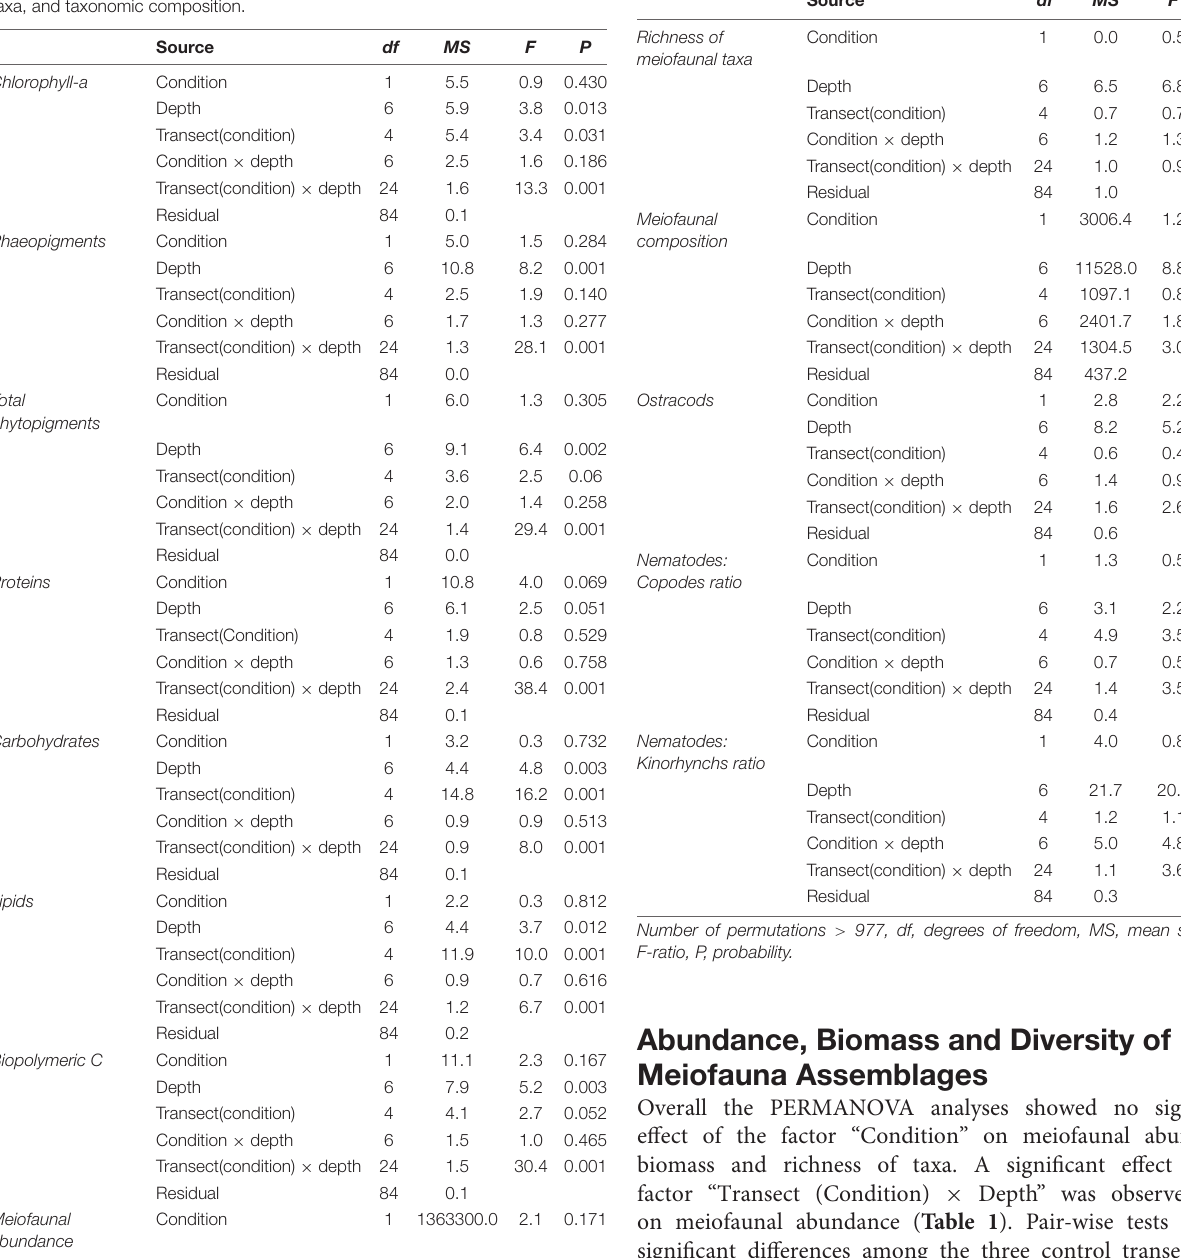
TABLE 1 | Output of PERMANOVA analyses on the concentrations of organic matter biochemical components, meiofaunal abundance, biomass, richness of taxa, and taxonomic